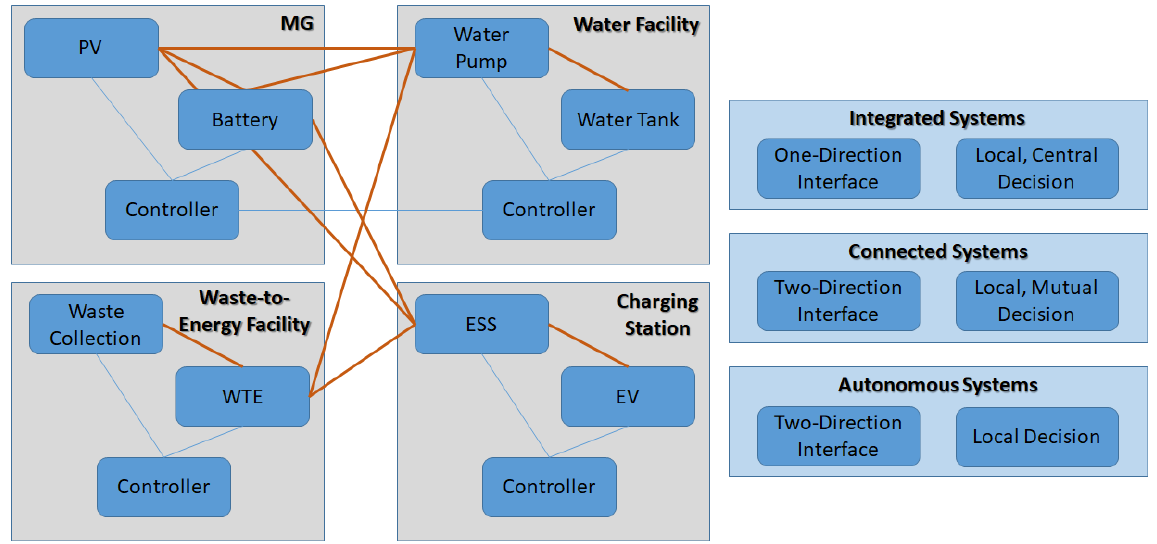
Figure 7. Case study of interfaces among energy–water–transportation–waste interconnected systems.